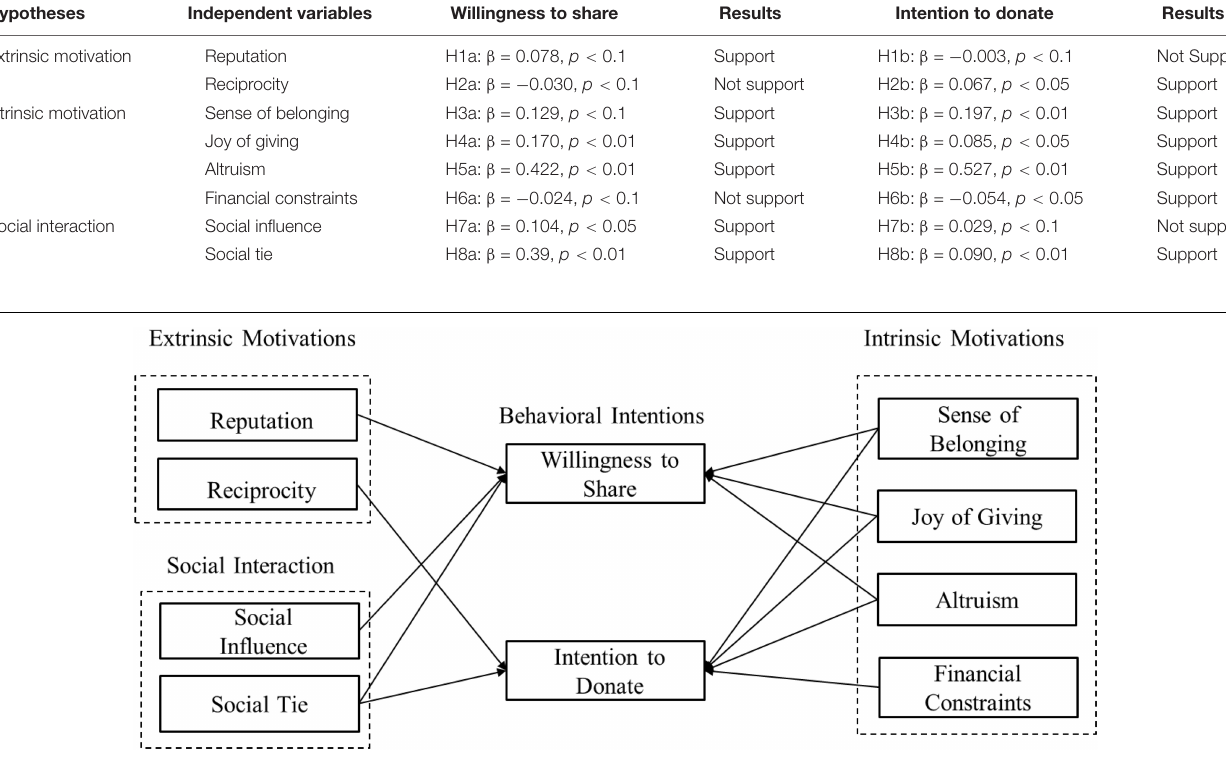
FIGURE 2 | Confirmatory model of motivations behind donors’ behavior intention.